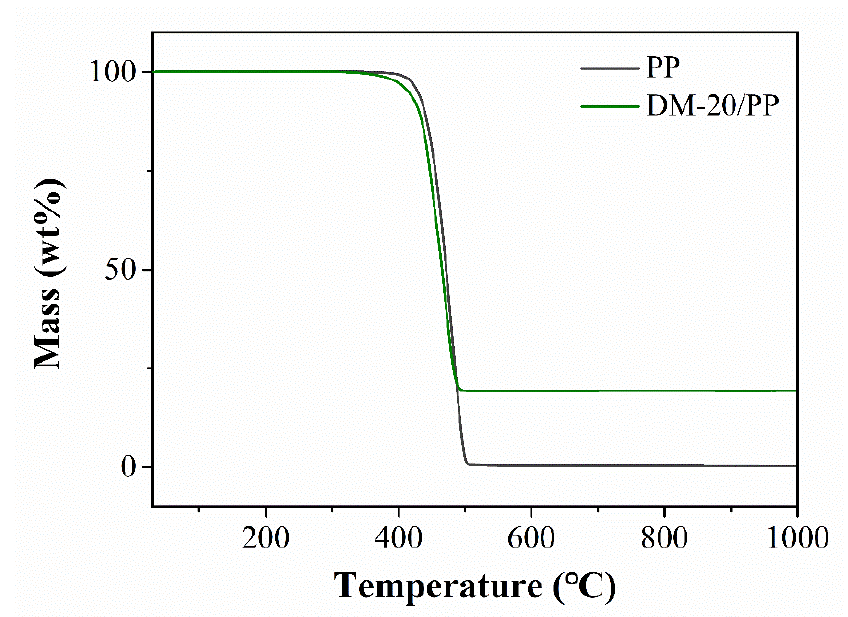
Figure 2. Thermogravimetric analyzer (TG ) curves of pure PP and DM–20/PP.